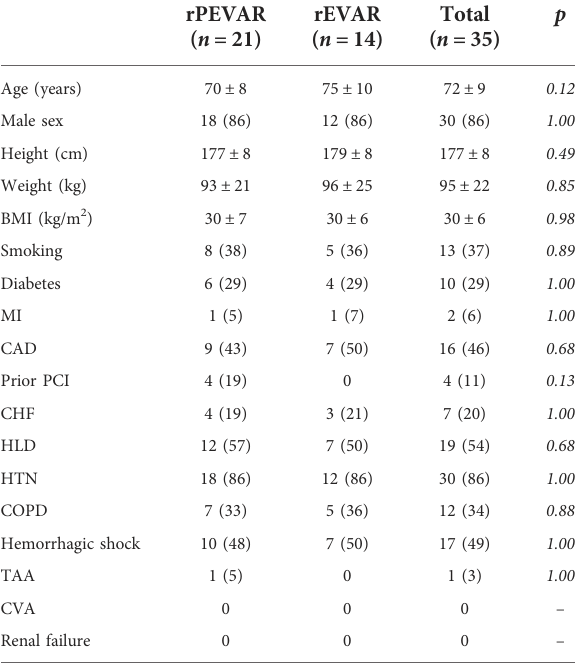
TABLE 1 Baseline characteristics of the rPEVAR and rEVAR